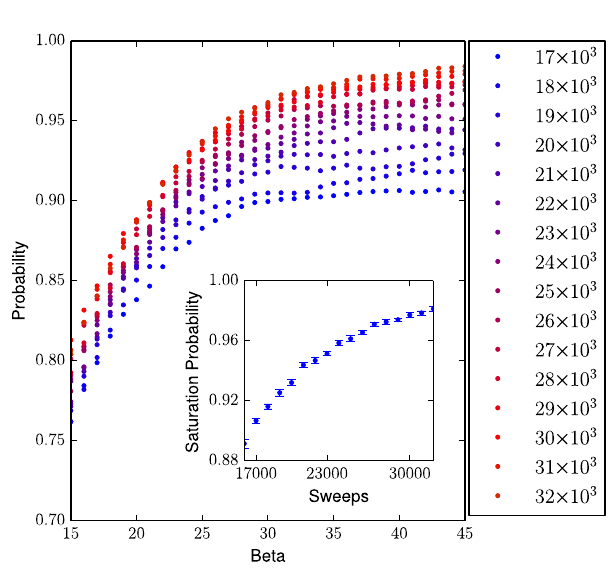
FIG. 9. Probability of success versus β for QMC with the D-Wave 2X schedule. Different colors correspond to different number of sweeps (see legend). The embedded plot shows the probability of success at saturation for different number of sweeps. We use periodic boundary conditions, which performed better than open boundary conditions in this